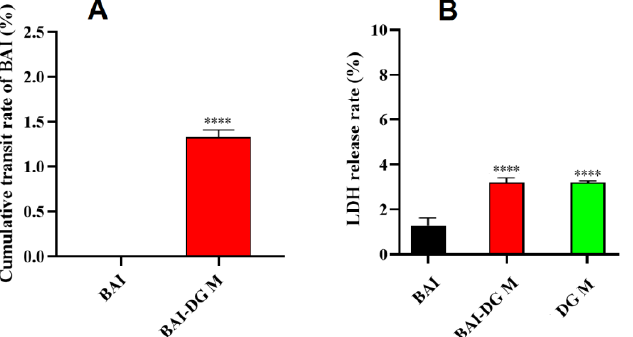
Figure 10. ( A ) Cumulative rate of transported pure BAI and BAI-DG Ms across the Caco-2 cell monolayer; ( B ) LDH release from Caco-2 cells after 2 h with the treatment of DG, BAI, and BAI-DG Ms. **** p < 0.001 compared with the BAI group.